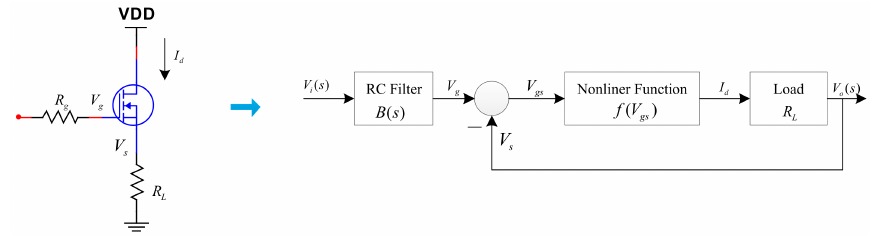
Figure 5. The control block diagram of the